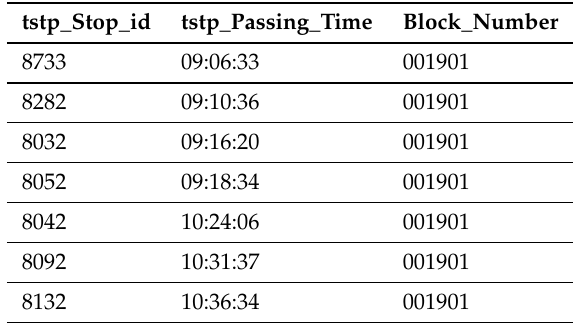
Table 6. Sample of the TripStop table.